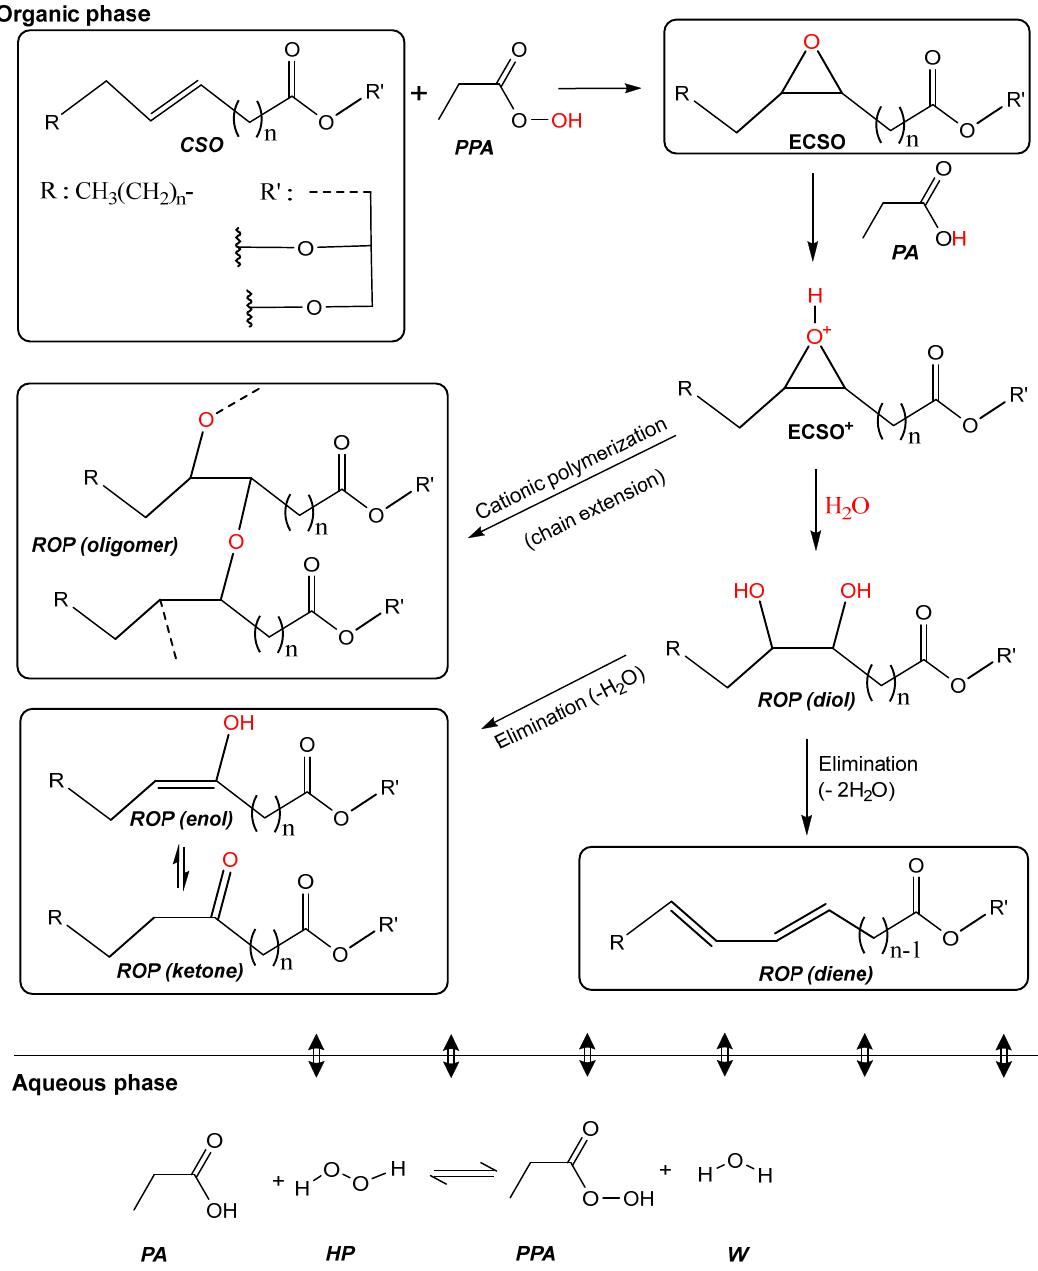
Figure 9. Reaction pathway for the epoxidation of cottonseed oil by perpropionic acid. (DB: double bond, EP: epoxide, ROP: ring ‐ opening products, W: water, PPA: perpropionic acid, PA: propionic acid, and HP: hydrogen peroxide).